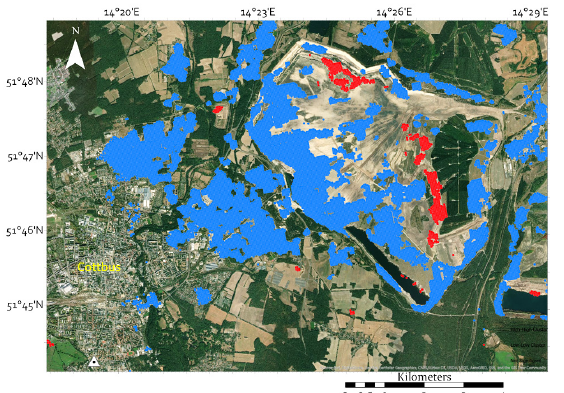
Figure 8. Cluster analysis of mean velocity (Figure 4). Red, significant subsidence; blue, significant uplift.